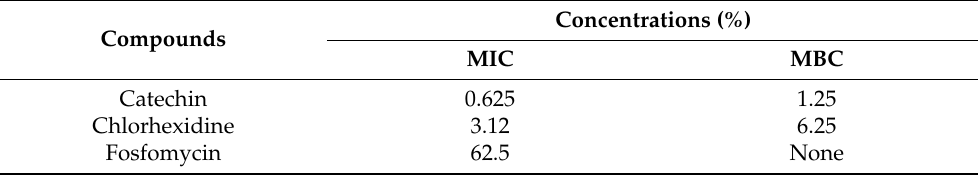
Table 3. MIC and MBC data of Catechin against E. faecalis ATCC 29212.